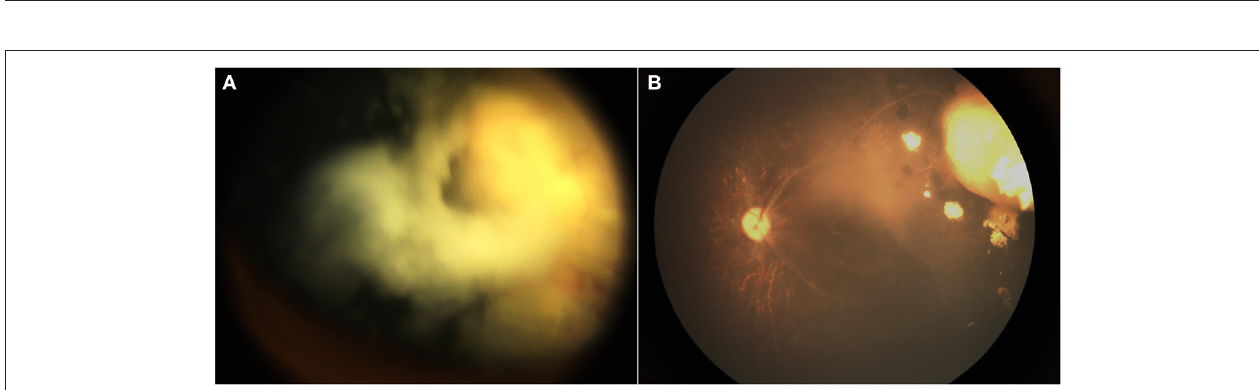
technique referred to as “selective ophthalmic artery infusion (SOAI)” with a balloon catheter, which temporarily occludes the internal carotid artery (distal to the OA orifice) and